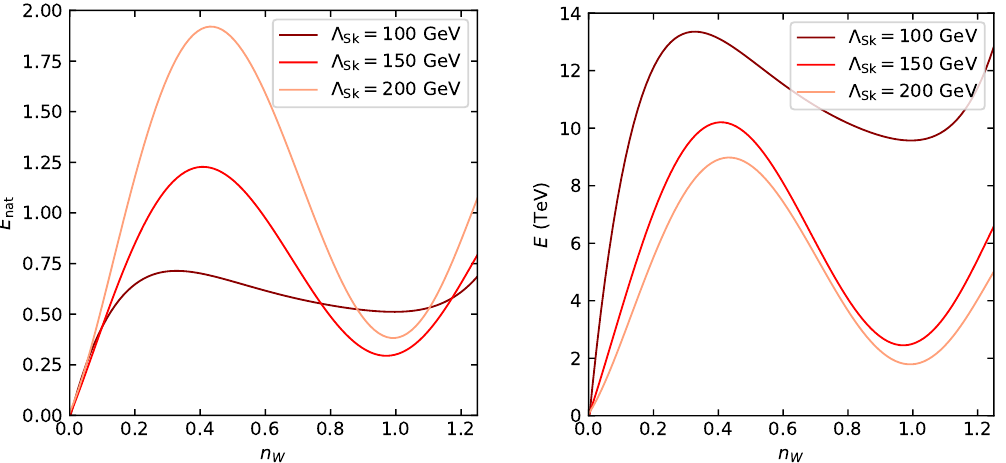
Figure 3 . Energy as a function of n W for different values of Λ . The figure on the left shows the dimensionless quantity E nat and the figure on the right gives the corresponding physical E in TeV. The (anti)-skyrmion solution corresponds to the local minimum in the vicinity of n W ’ 1 and the new spaleron-like barrier is around n W ’ 1 / 2 . Perturbative vacuum is the global minimum at n W = 0